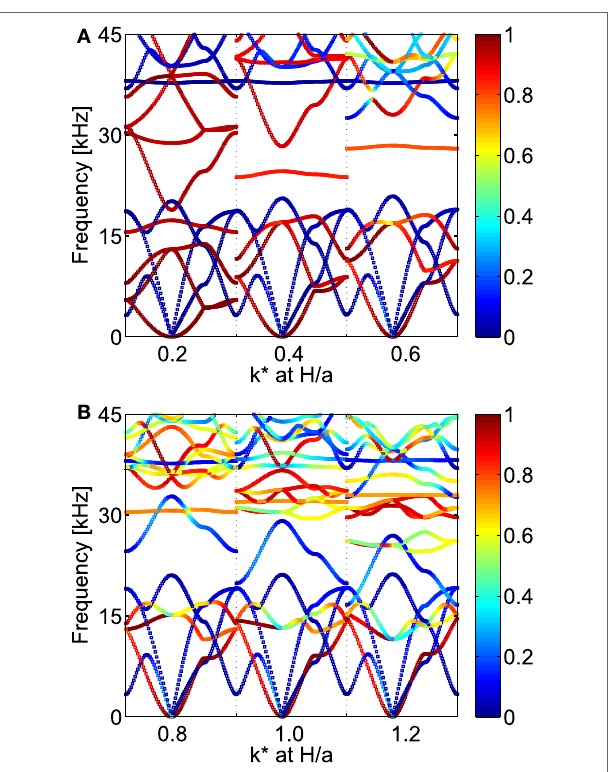
FigUre 3 | Parametric study showing the influence of the height to lattice parameter ratio H/a on the band structure for the case study of a unit cell with a cross-like cavity. Dispersion diagrams for (a) H/a = 0.2–0.6 and (B) H/a = 0.6–1.2 are reported. The color of the curves indicates the mode polarization, ranging from pure in-plane (blue) to pure out-of-plane (red). FigUre 2 | Schematic representation of the first irreducible Brillouin zone for